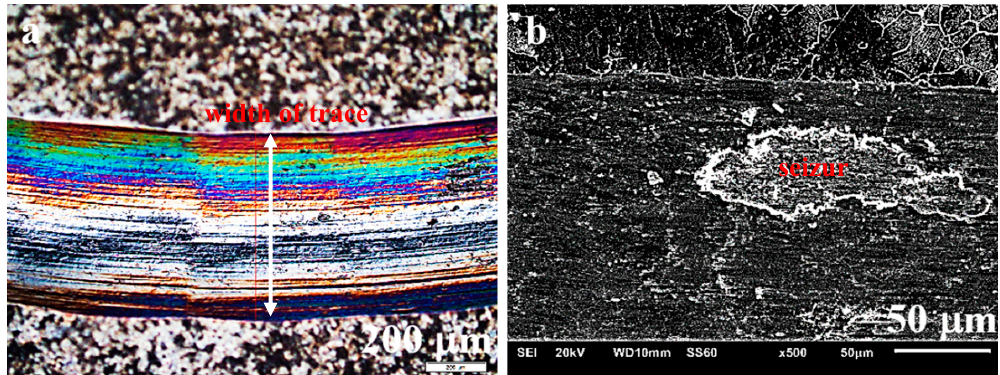
Figure 14. Surface of the NiAl sinter showing: ( a ) track (path) of ball travel in the ball-on-disc friction process, and ( b ) seizure resulting from this process.